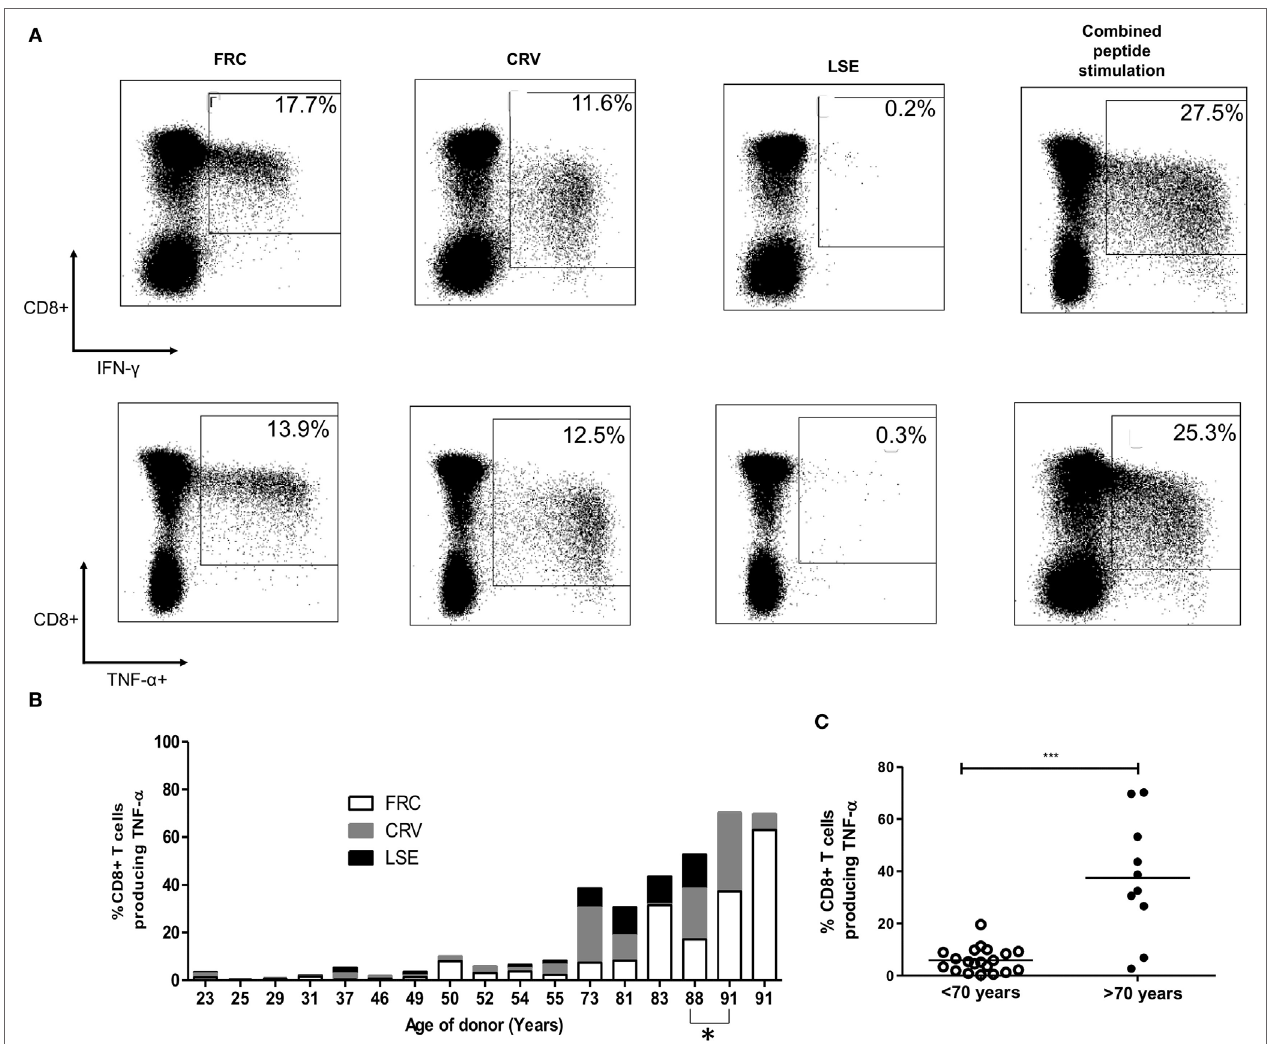
FigUre 2 | CD8 + T-cell responses against cytomegalovirus (CMV) peptides restricted by HLA-Cw*0702 are not cross-reactive, and their aggregate response represents a large percentage of the total CD8 + T-cell repertoire within older donors. (a) CMV-specific T-cell responses to different peptides do not show evidence of cross reactivity. PBMC from a CMV-seropositive donor aged 81 years was stimulated with either FRC (left), CRV (middle), LSE peptide (right), or all three peptides (far right) before intracellular cytokine staining for IFN- γ (top row) and TNF- α production (bottom row). (b) Distribution of individual peptide-specific CD8 + T-cell responses producing TNF- α within 16 donors. The TNF- α response to each peptide stimulation is shown as a percentage of the total CD8 + T-cell repertoire within individual donors ( y -axis). The age of the donor in years is shown on the x -axis. One donor is included at subsequent time points (88 and 91 years) indicated by *. (c) Total magnitude of CMV-specific CD8 + T-cell response restricted by HLA-Cw*0702 within individual donors. Each circle represents the aggregate of the FRC, CRV, and LSE-specific CD8 + T-cell responses within individual donors as identified in panel (a) . White circles represent donors < 70 years of age, and black circles represent donors > 70 years of age. Lines represent mean, and significant difference was determined using Mann–Whitney tests in GraphPad Prism 6 (*** p <